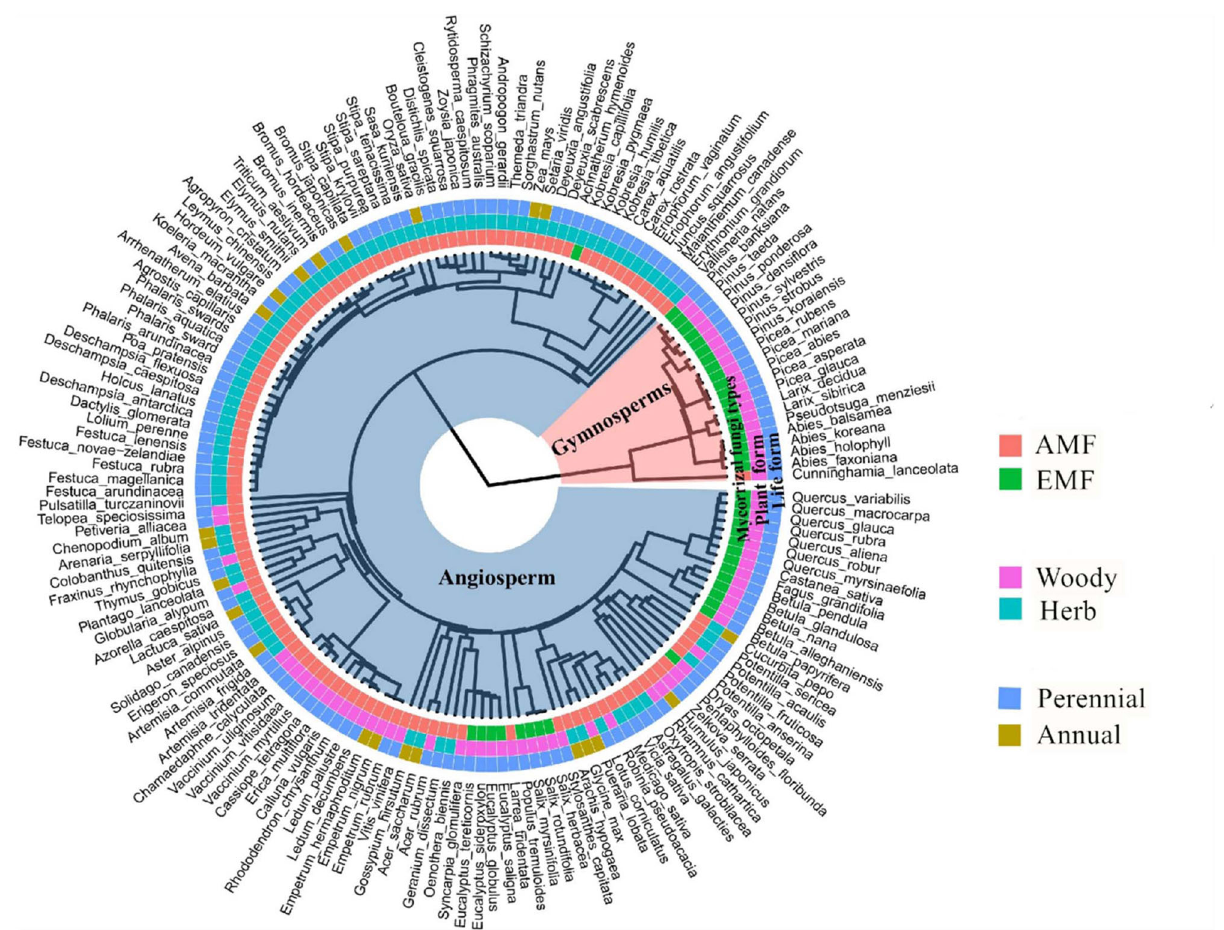
Fig. 2 | Phylogenetic tree of plant species used in this study. This phylogenetic tree is based on 164 vascular plant species (consisting of both gymnosperms and angiosperms), which were included to estimate the weighted response ratio of root:shootratio,planttotalbiomass,above-andbelowgroundbiomasstowarming.